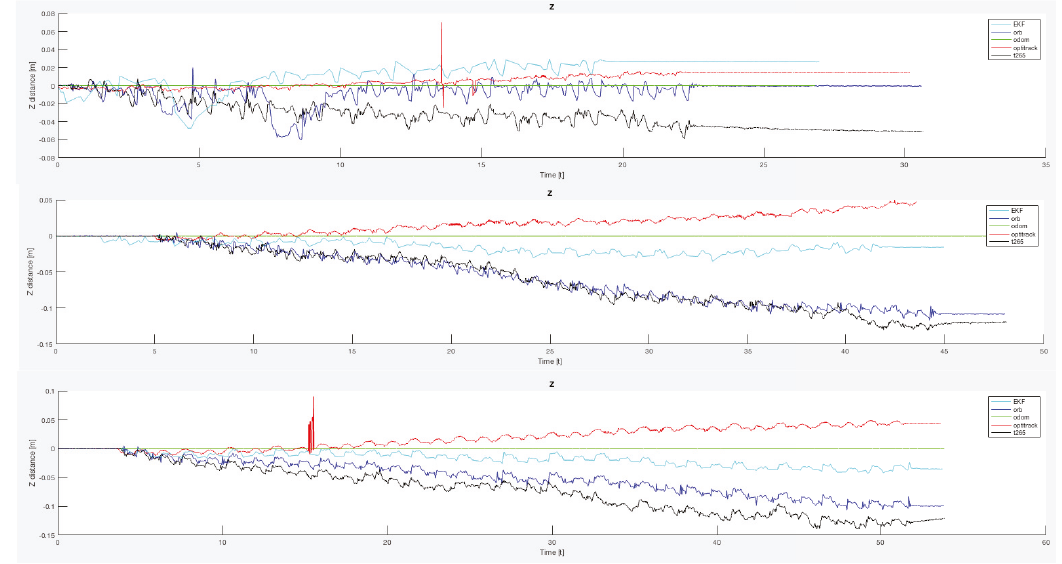
Figure 24. Indoor tests scenario 2. Test 1. Trials 1–5. Final error Z position.